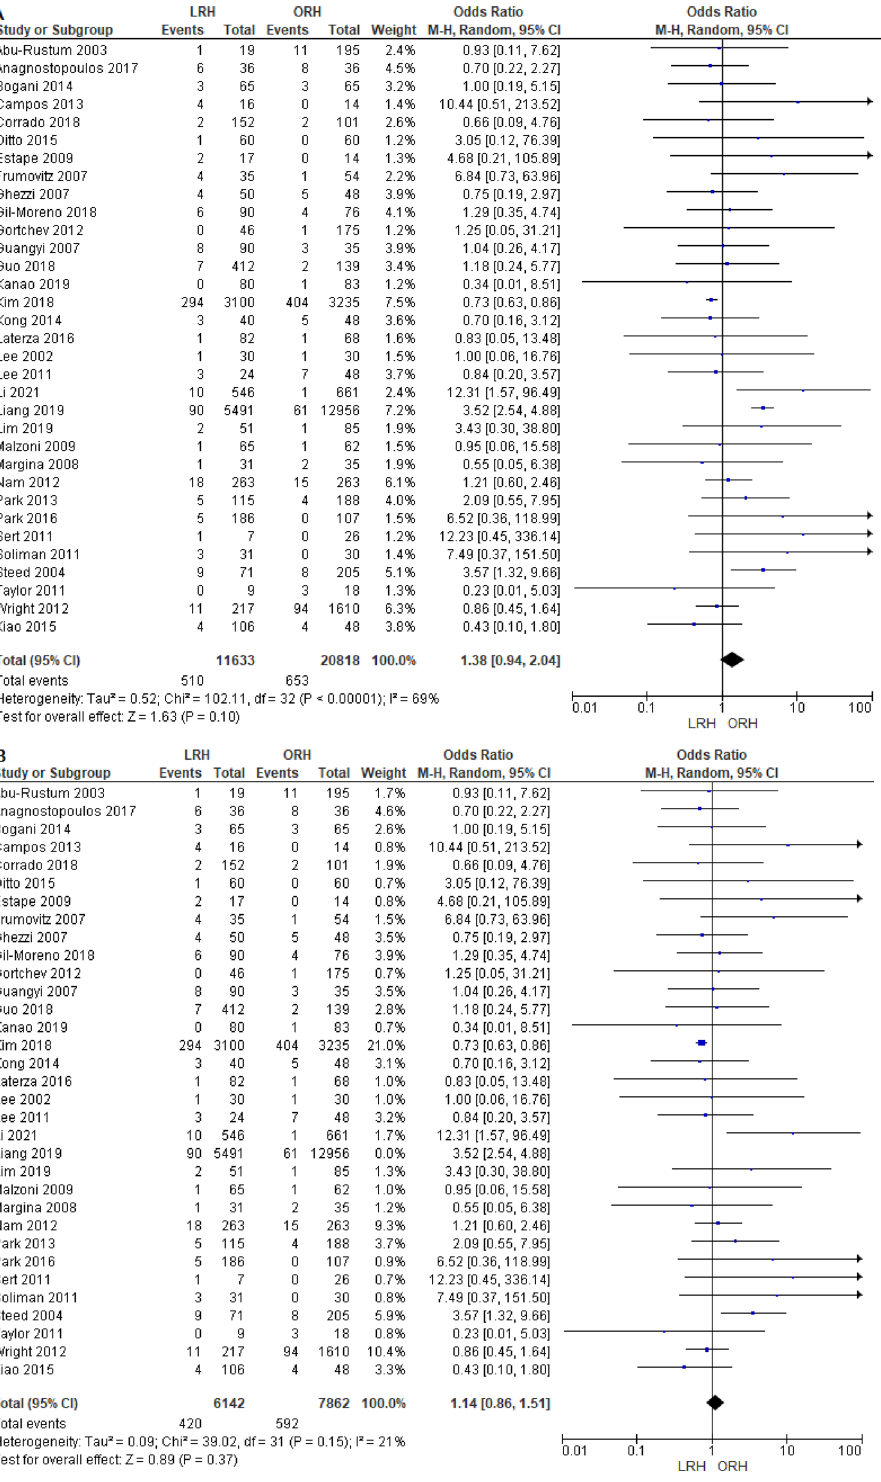
Figure 4. Forest plot of the rate of intraoperative complications before ( A ) and after ( B ) solving for heterogeneity by excluding the Liang et al.